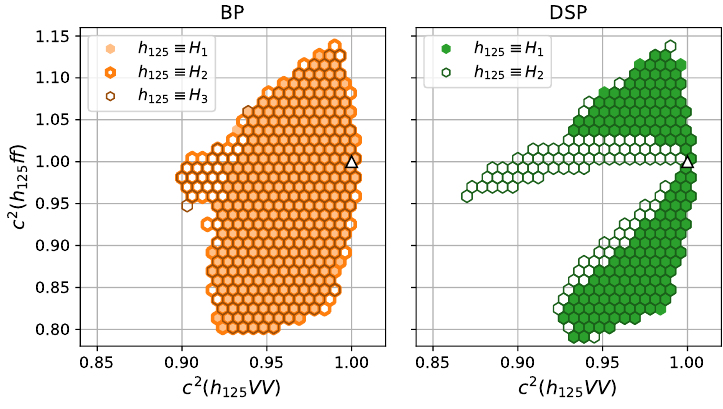
Figure 1 . Coupling modi(cid:12)ers relative to the SM for the couplings of h 125 to fermions, c ( h 125 (cid:22) ff ), and to gauge bosons, c ( h 125 V V ), for the Broken Phase (left) and for the Dark Singlet Phase (right). The white triangle indicates the SM